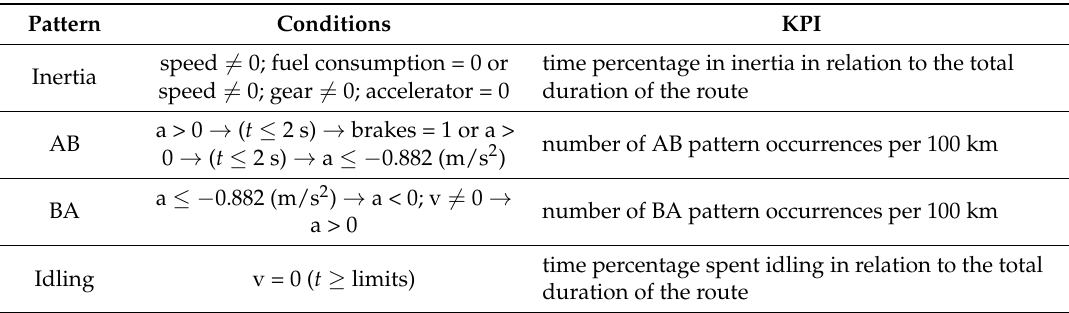
Table 2. Summary of the efficiency